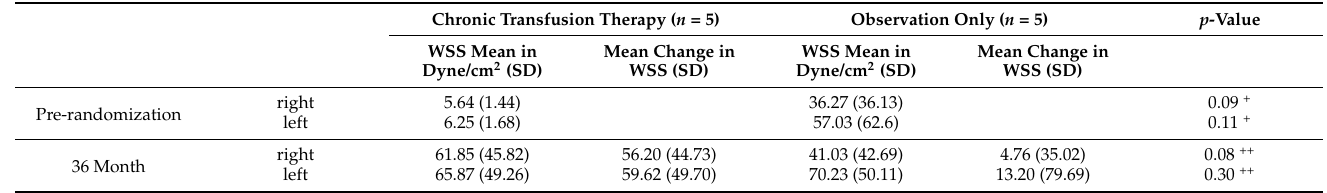
Table 4. Comparison of changes in wall shear stress (WSS) in observation and chronic RBC transfusion arms.